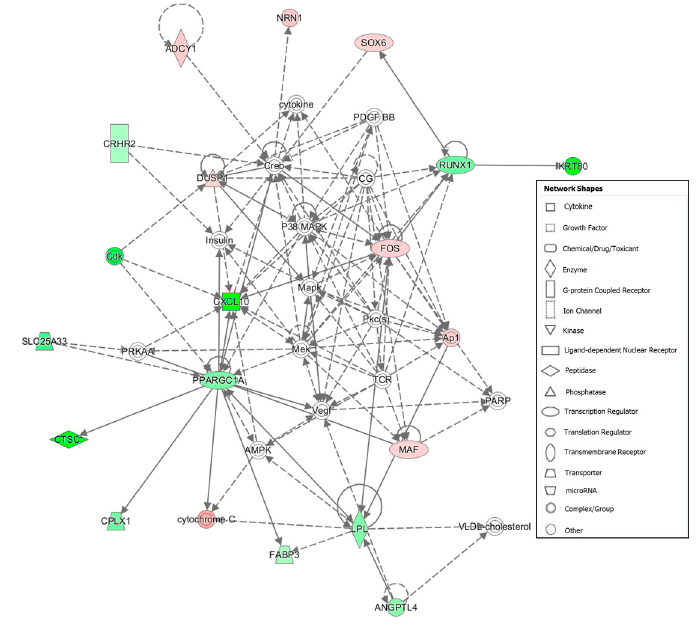
Figure 1. Gene network #5: Connective Tissue Development and Function, Lipid Metabolism, Tissue Morphology. Genes up-regulated and down-regulated in the Tender group are represented in green and red colors,